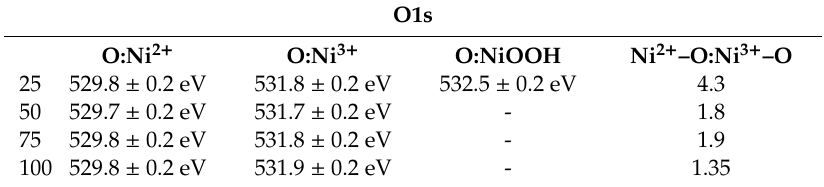
Table 5. Binding energy values of oxygen bonded in the NiO and Ni 2 O 3 states and their respective ratios.